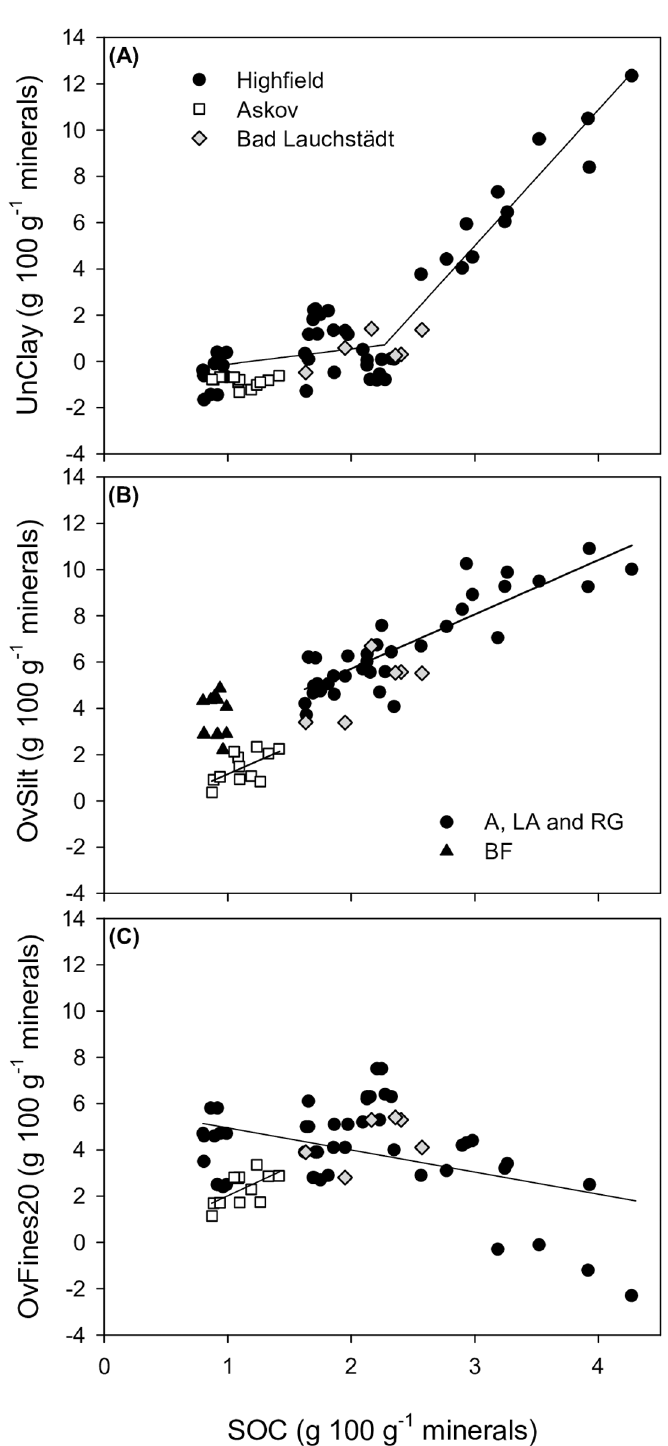
Fig 2. Underestimation of clay content ( < 2 μ m), overestimation of silt content (2–20 μ m) and overestimation of Fines20 content ( < 20 μ m) caused by omitting hydrogen peroxide (H 2 O 2 ) pretreatment as a function of SOC content. (A) Underestimation of clay content (UnClay)caused by omitting H 2 O 2 pretreatment plotted againstSOC content. The soil samples from Highfield,Bad Lauchsta¨dt and Askov are shown with black, grey and white symbols, respectively.The broken-stick model is indicated for Highfield( n = 48). (B) Overestimation of silt content (OvSilt) caused by omitting H 2 O 2 pretreatment